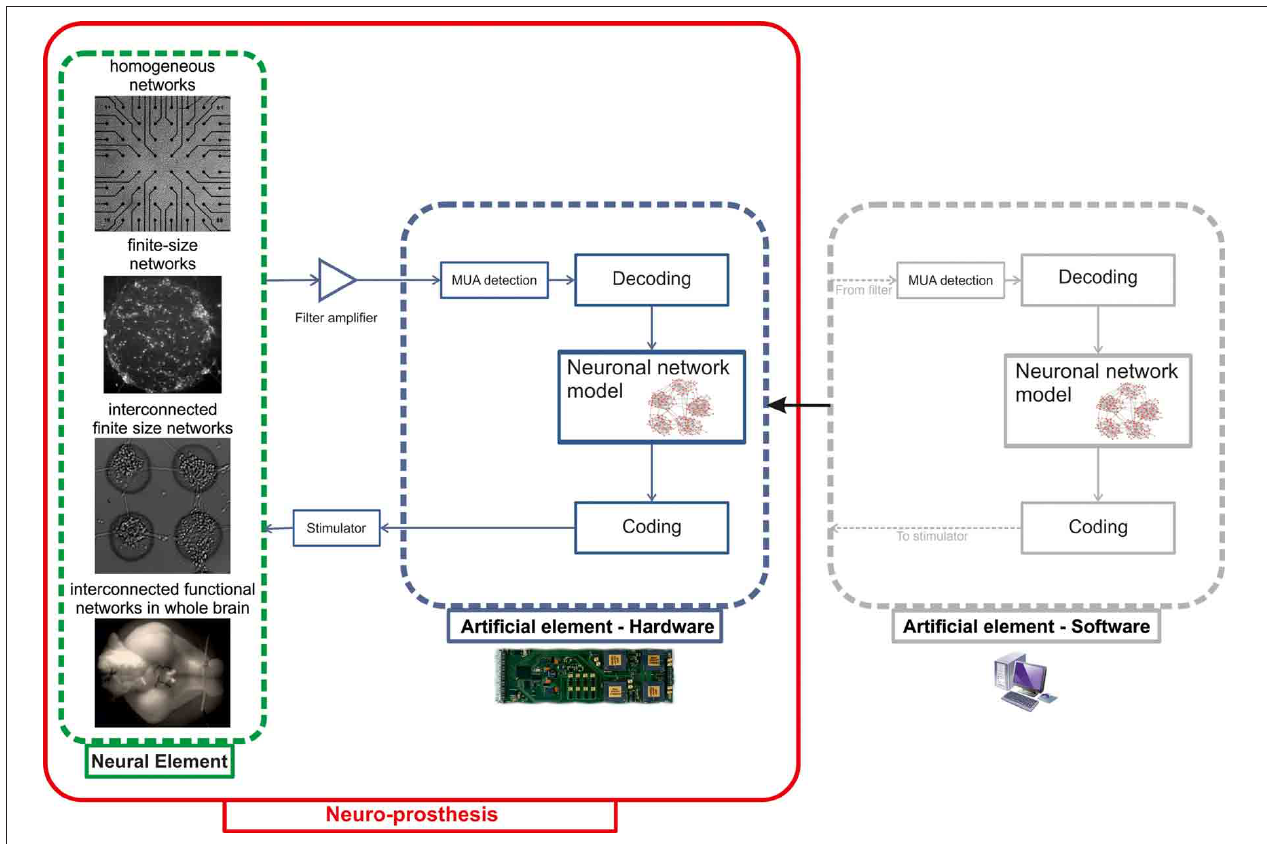
FIGURE 9 | Schematic representation of the closed-loop system to be implemented as a proof-of-concept neuro-prosthesis. Different in vitro neural models with increasing degrees of architectural complexity (“Neural element”) will be interfaced to a hardware neuromorphic chip (“Artificial element—Hardware”), implementing both